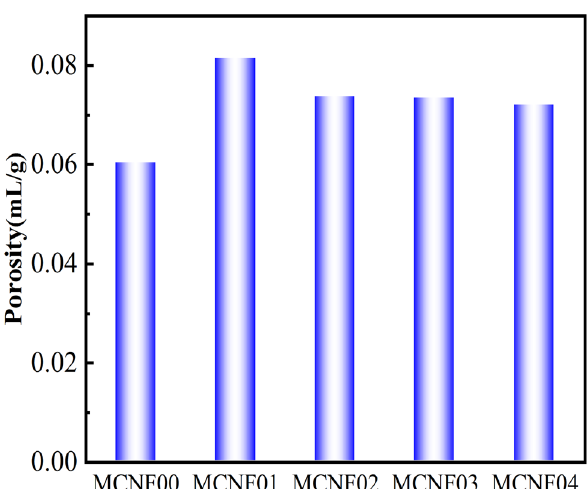
Figure 10. Porosity of MCNF